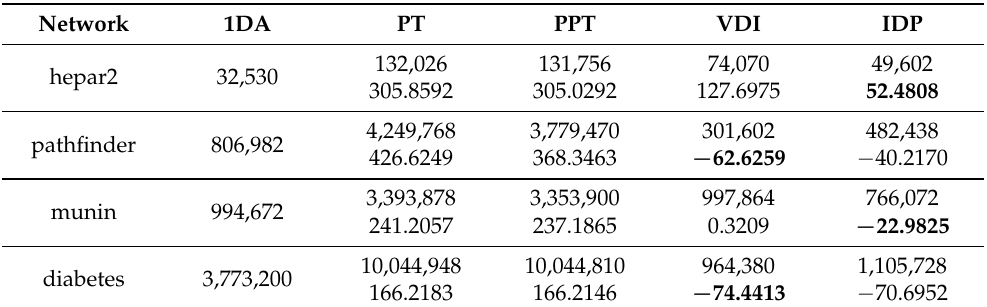
Table 6. Global memory size analysis. Bold typeface denotes the structure with the best saving percentage (or with the smallest increase